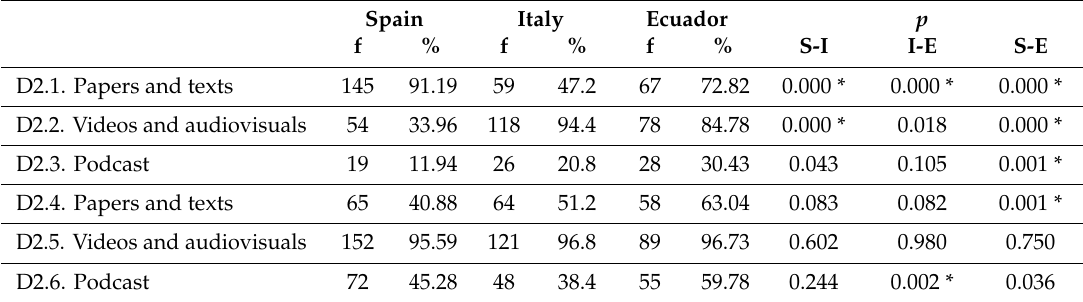
Table 3. Di ff erences among countries for D2 and basic statistics (N =